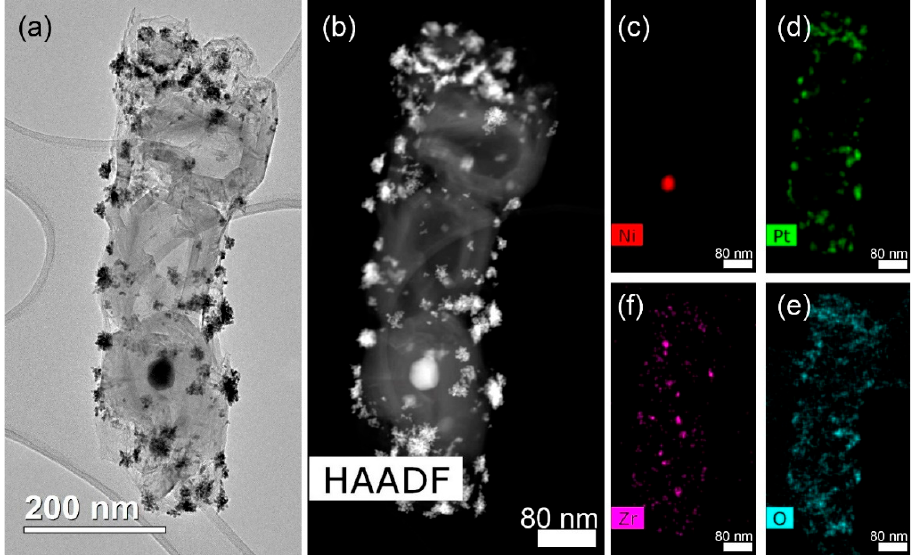
Figure 10. CNF with crystalline structure: ( a ) BF TEM image; ( b ) STEM HAADF image; and ( c – f ) elemental mapping for sample 6